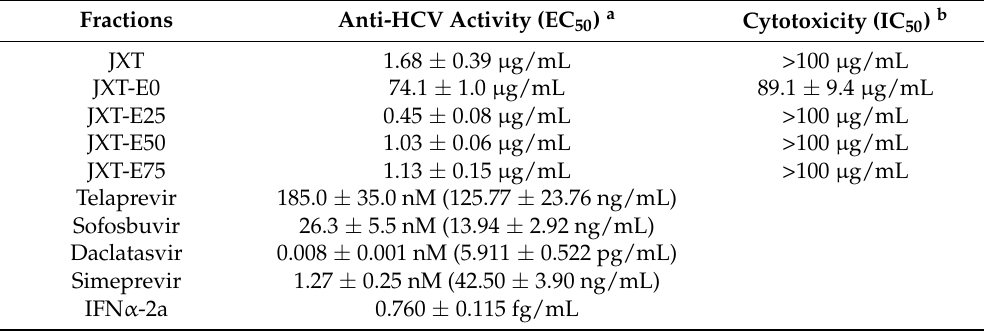
Table 2. EC 50 and IC 50 of S. suberectus. fractions and approved anti-HCV therapy on Huh-luc/neo-ET cells. Impact on HCV replication and cytotoxicity were evaluated in Huh-luc/neo-ET cells for 72 h following the methods described in the Materials and Methods